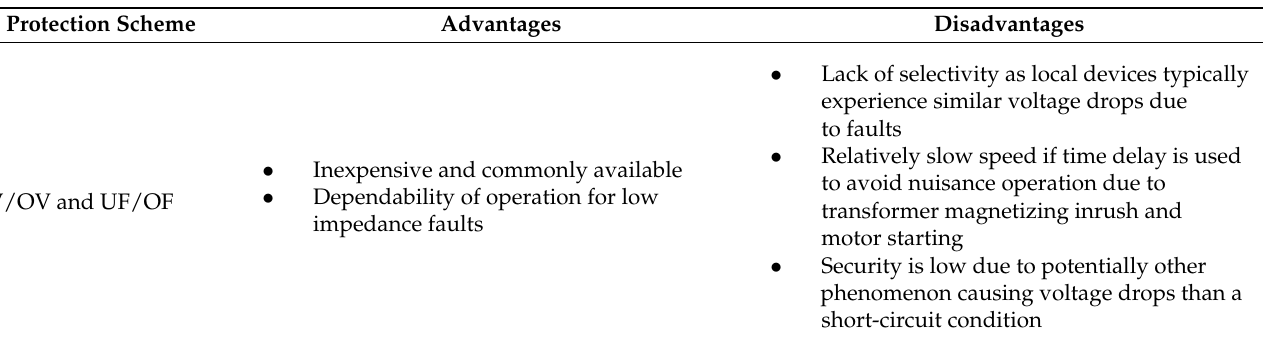
Table key: CT, current transformer; OC, Over-Current; OF, Over-Frequency; OV, Over-Voltage; UF, Under-Frequency; UV, Under-Voltage; VT, voltage